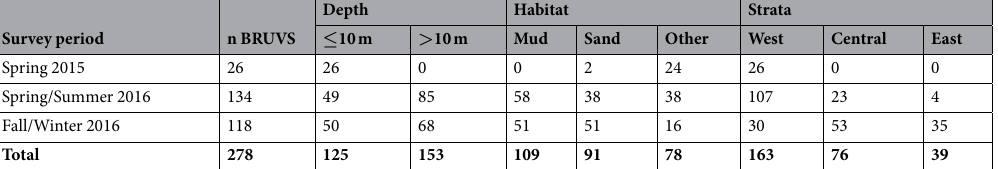
Table 1. Summary of the number of Baited Remote Underwater Surveys ( n BRUVS) completed in 2015 and 2016 by Depth , Habitat and Strata .